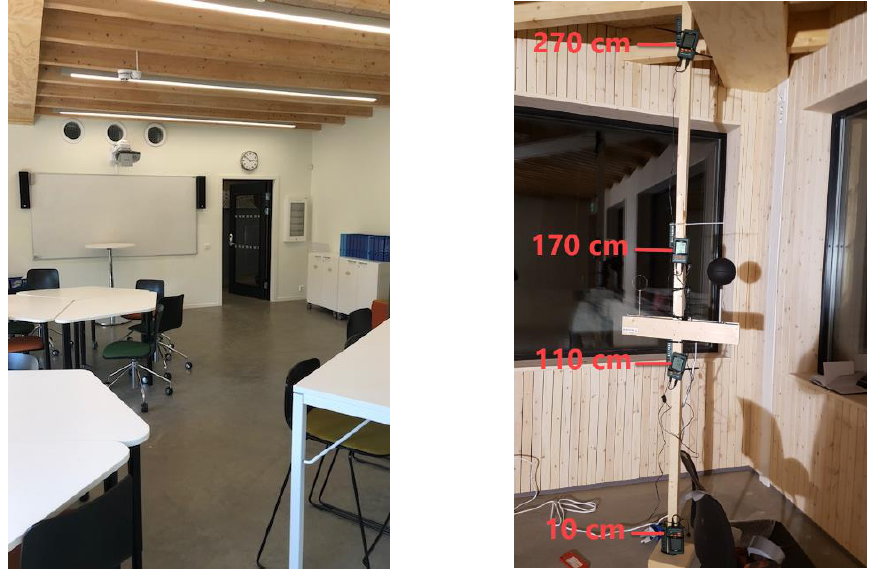
Figure 8. Photos of the classroom with measurement points for temperature and CO 2